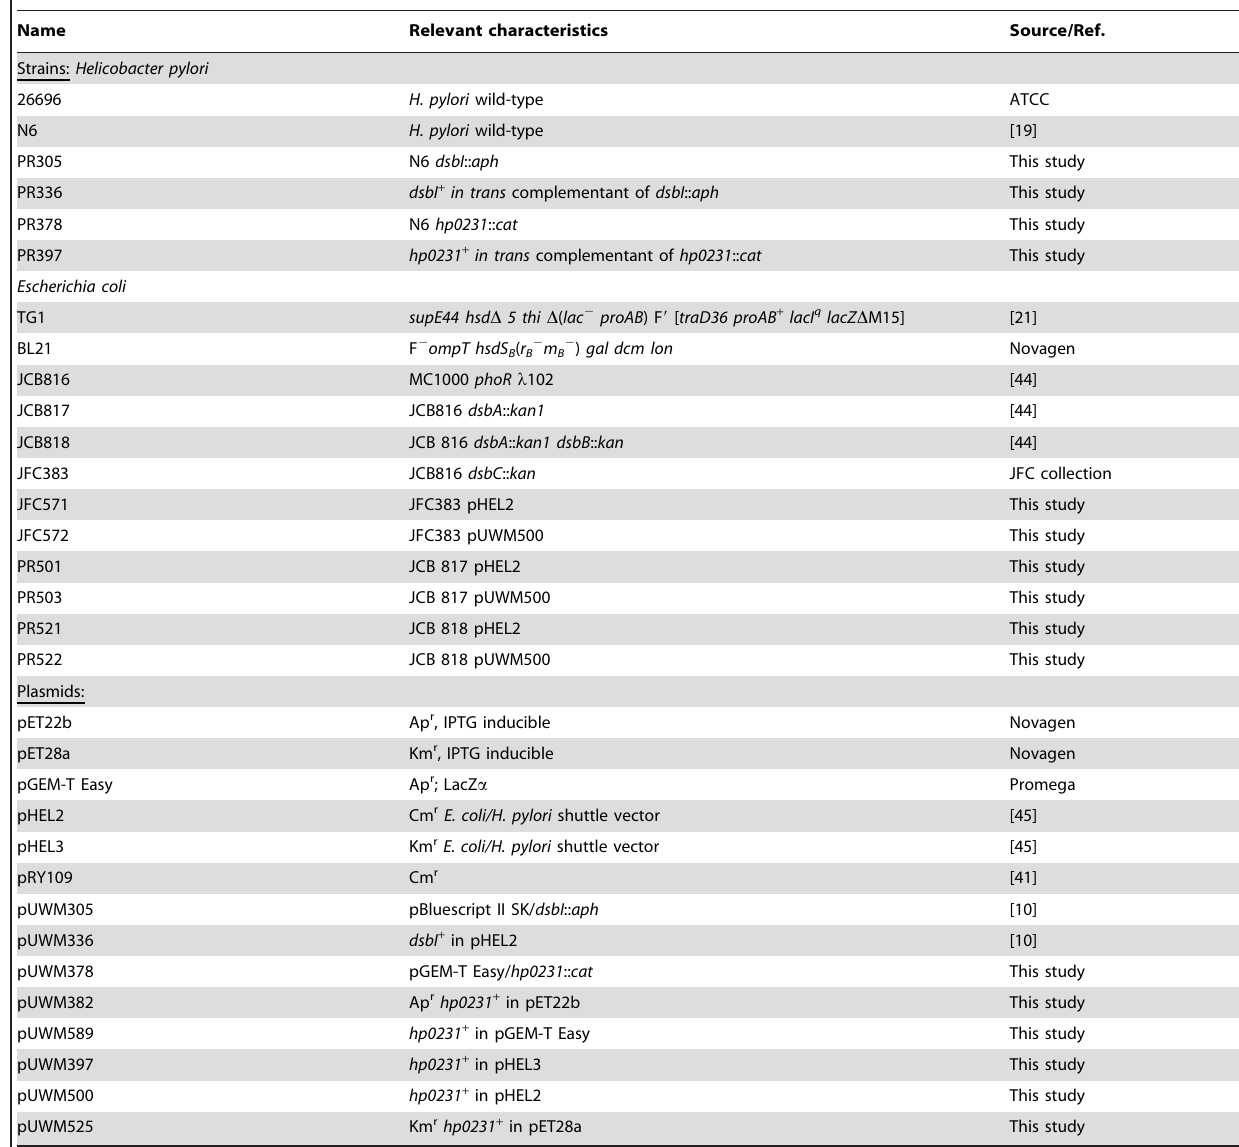
Table 1. Bacterial strains and plasmids used in this study.